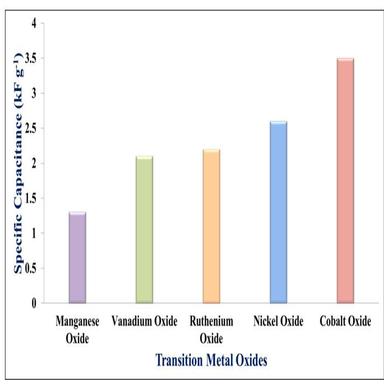
Comparative study of theoretical Csp in TMO materials.